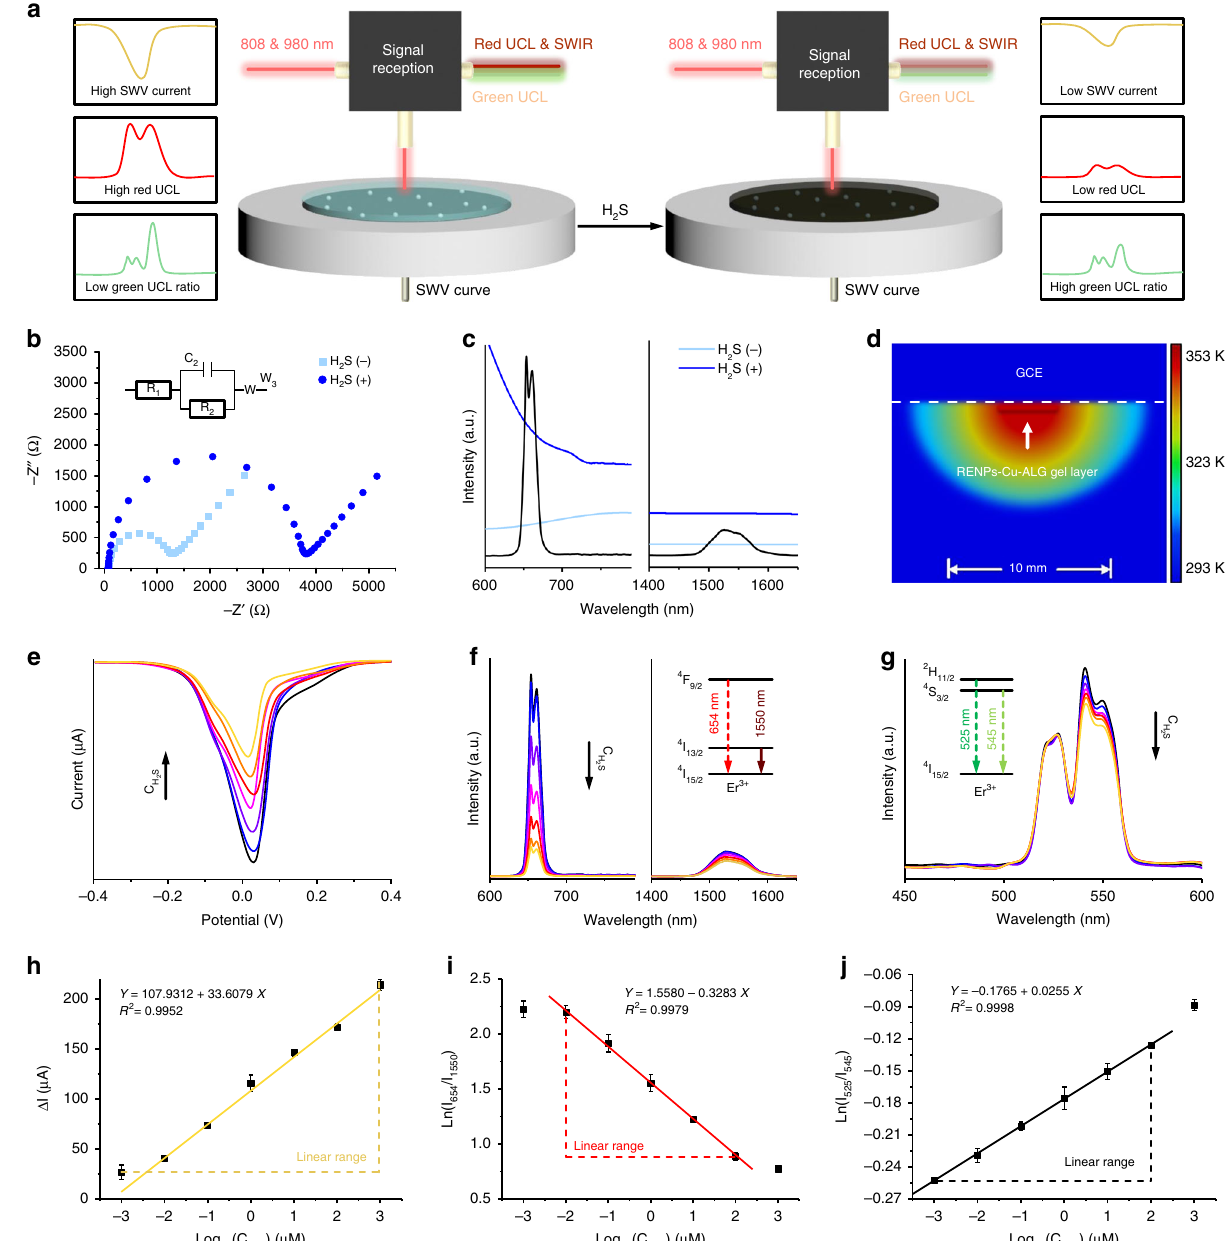
Fig. 2 H 2 S quantifying capacities of three-channel platform. a Schematic illustrations of the H 2 S quantifying mechanism of the rationally constructed three- channel platform. Electrochemical impedance spectra of three-channel platform ( b ) and ultraviolet – visible – near-infrared spectra of RENPs – Cu – ALG gel ( c ) in the absence and presence of H 2 S. d Finite element simulation of the heat conduction of electrode surface induced by the photothermal process. GCE was the abbreviation of glassy carbon electrode. SWV curves ( e ), luminescence spectra ( f ), and thermal-sensitive UCL curve ( g ) of three-channel platform in response to various C H2S . Linear relationship between Δ I ( h ), Ln(I 654 /I 1550 ) ( i ), and Ln(I 525 /I 545 ) ( j ) of three-channel platform and various C H2S . Data are represented as mean ± SD ( n =